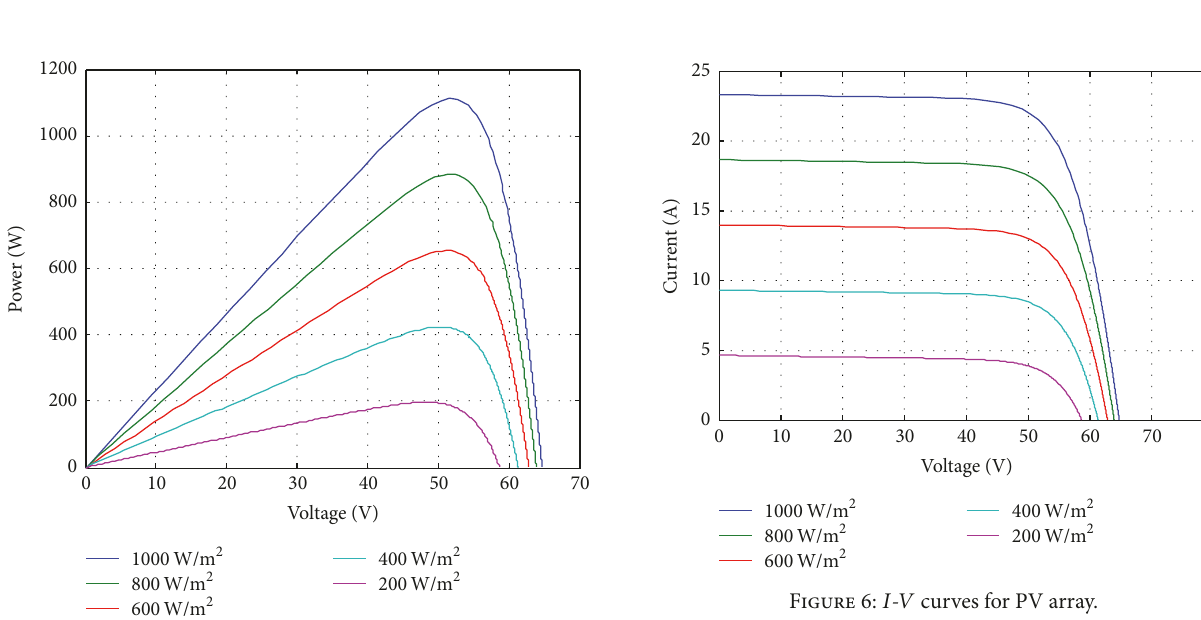
Figure 4: The model of a ISOFOTON I-75 array in Matlab/Simulink.